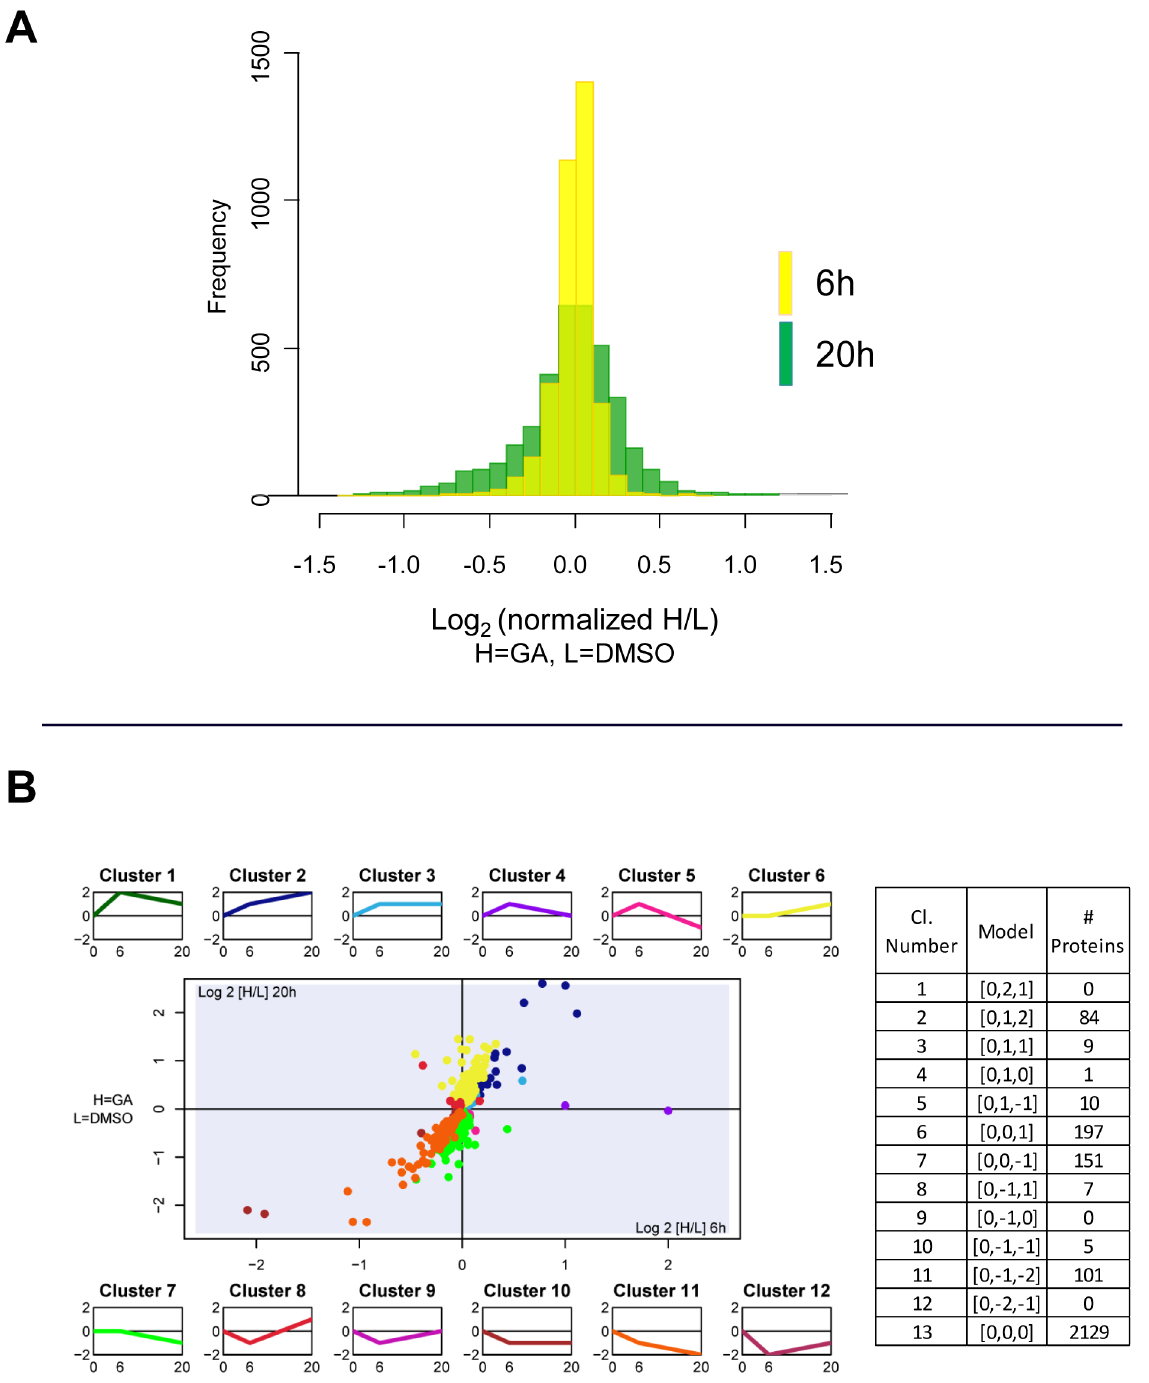
Figure 2. Distribution of stSILAC quantitative ratios at two time points of GA treatment and clustering of proteins with significant changes. A ) Histograms of normalized treated/control ratios for the stSILAC 6h (yellow), and 20h (green) datasets (4050 proteins). B ) Twelve possible patterns of change upon GA treatment were defined (small plots) as models for correlation clustering. Additional clusters (not shown) included proteins with no significant changes (cluster 13) and proteins with data only at one time point (cluster 14). The number of genes (encoding proteins) identified in each cluster are indicated in the box. doi:10.1371/journal.pone.0080425.g002 respectively, and they appeared to establish a link between misfolded proteins. Unexpectedly, a substantial proportion of degraded clients and the proteasome complex (Fig. 3B). Some the ubiquitination machinery that was connected to client components of the ubiquitination machinery were also proteins by protein-protein interactions eventually suffered the induced, presumably to help with the increased load of same fate.